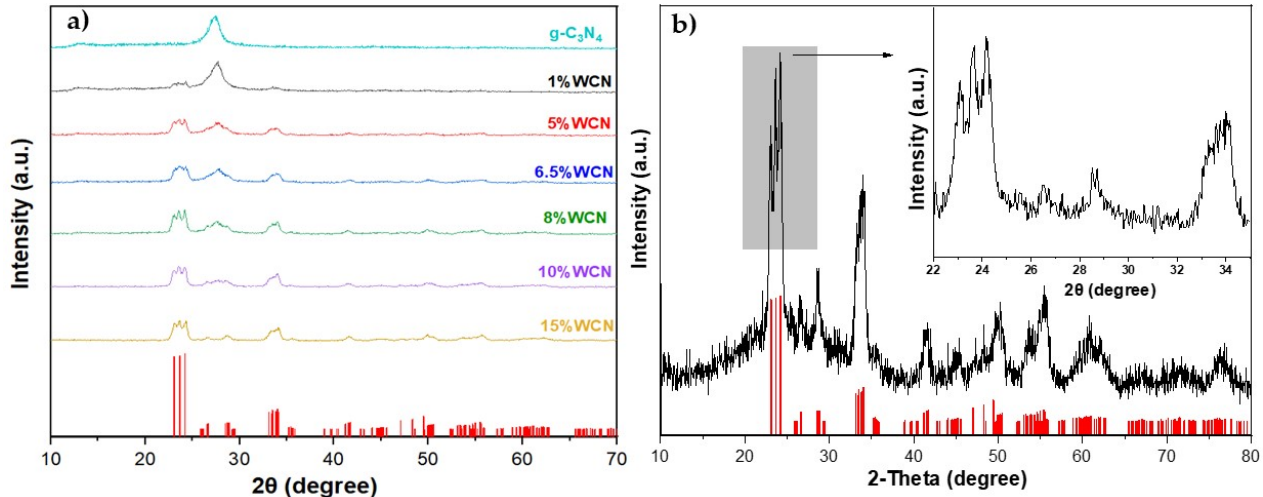
Figure 1. XRD patterns of g-C 3 N 4 and WO 3 /g-C 3 N 4 composite materials ( a ) and WO 3 fibers ( b ). Table 1. Physicochemical properties of prepared